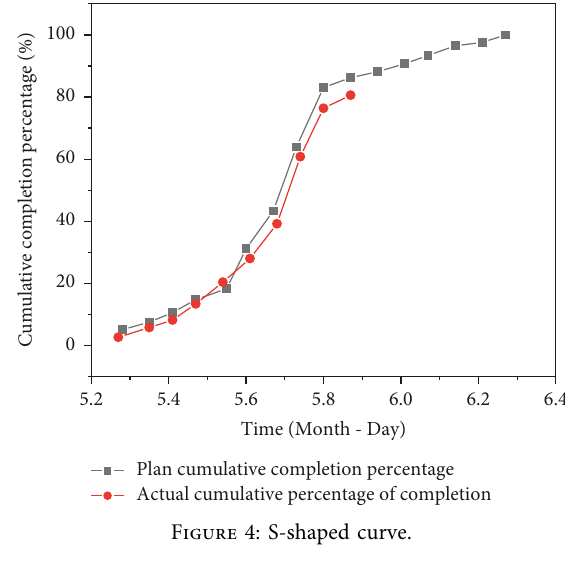
Figure 4: S-shaped